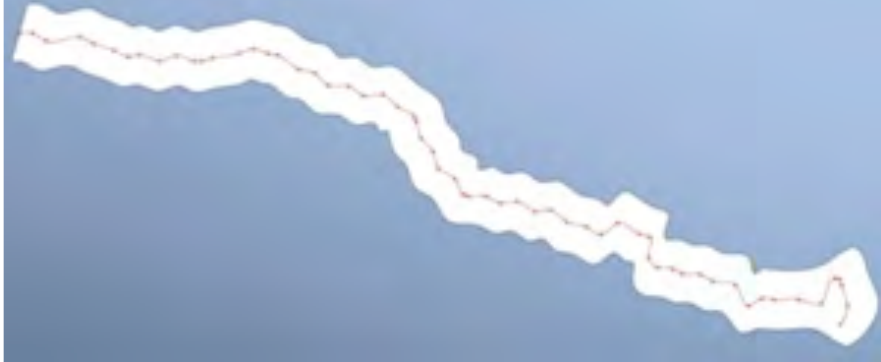
Figure 3. The top-view of the entire slalom route in Naoussa.